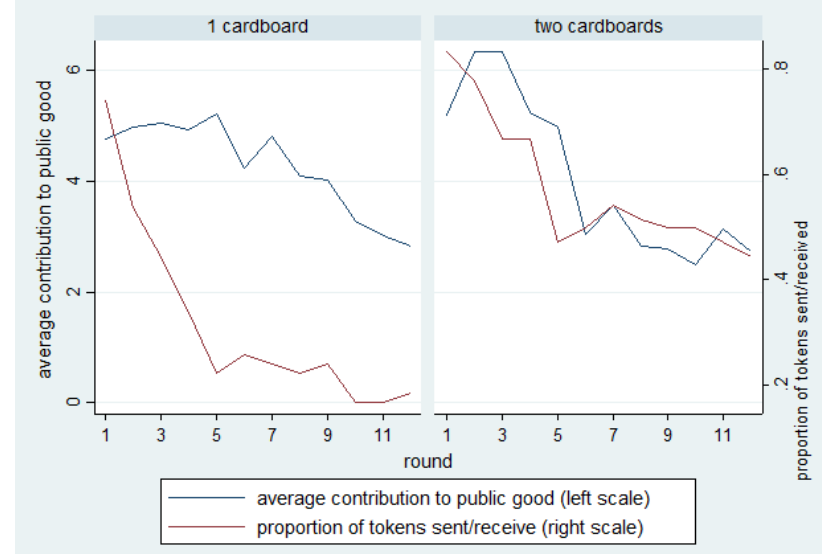
Figure 5. Contributions to the public good and proportion of tokens sent/received in each round (cardboard studies only).